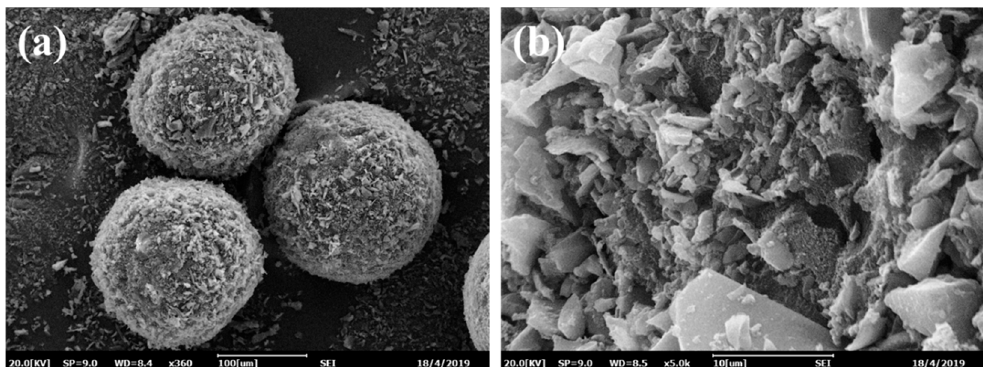
Figure 2. The SEM images of MMIPMs: Integral morphology ( a ) and surface morphology ( b ).